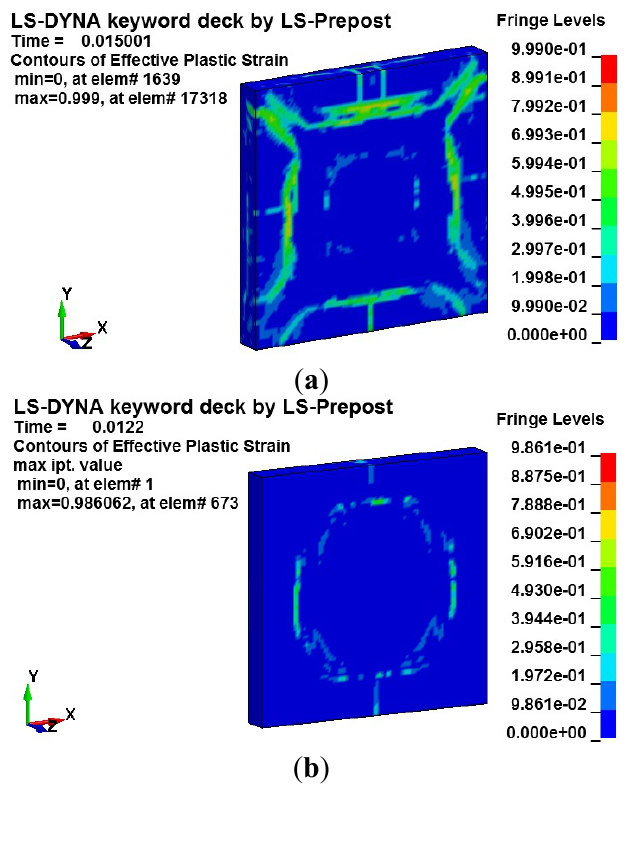
Figure 7. Damage pattern by explicit analyses: ( a ) Normal concrete wall; ( b ) Protected concrete wall by foam